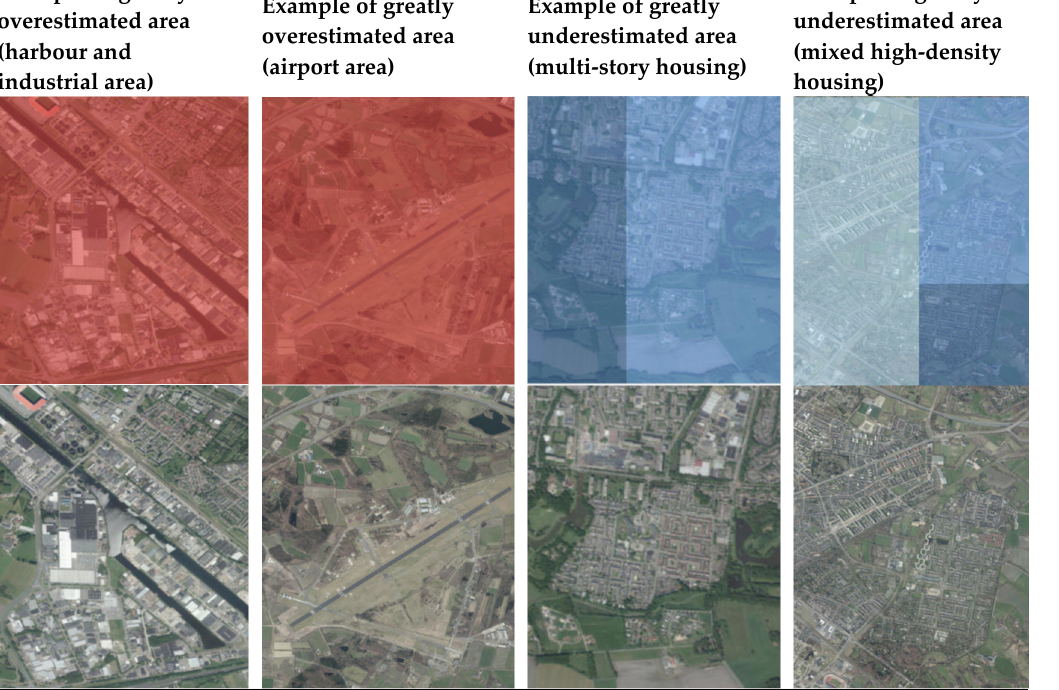
Figure 5. Examples of very greatly over- and underestimated areas in